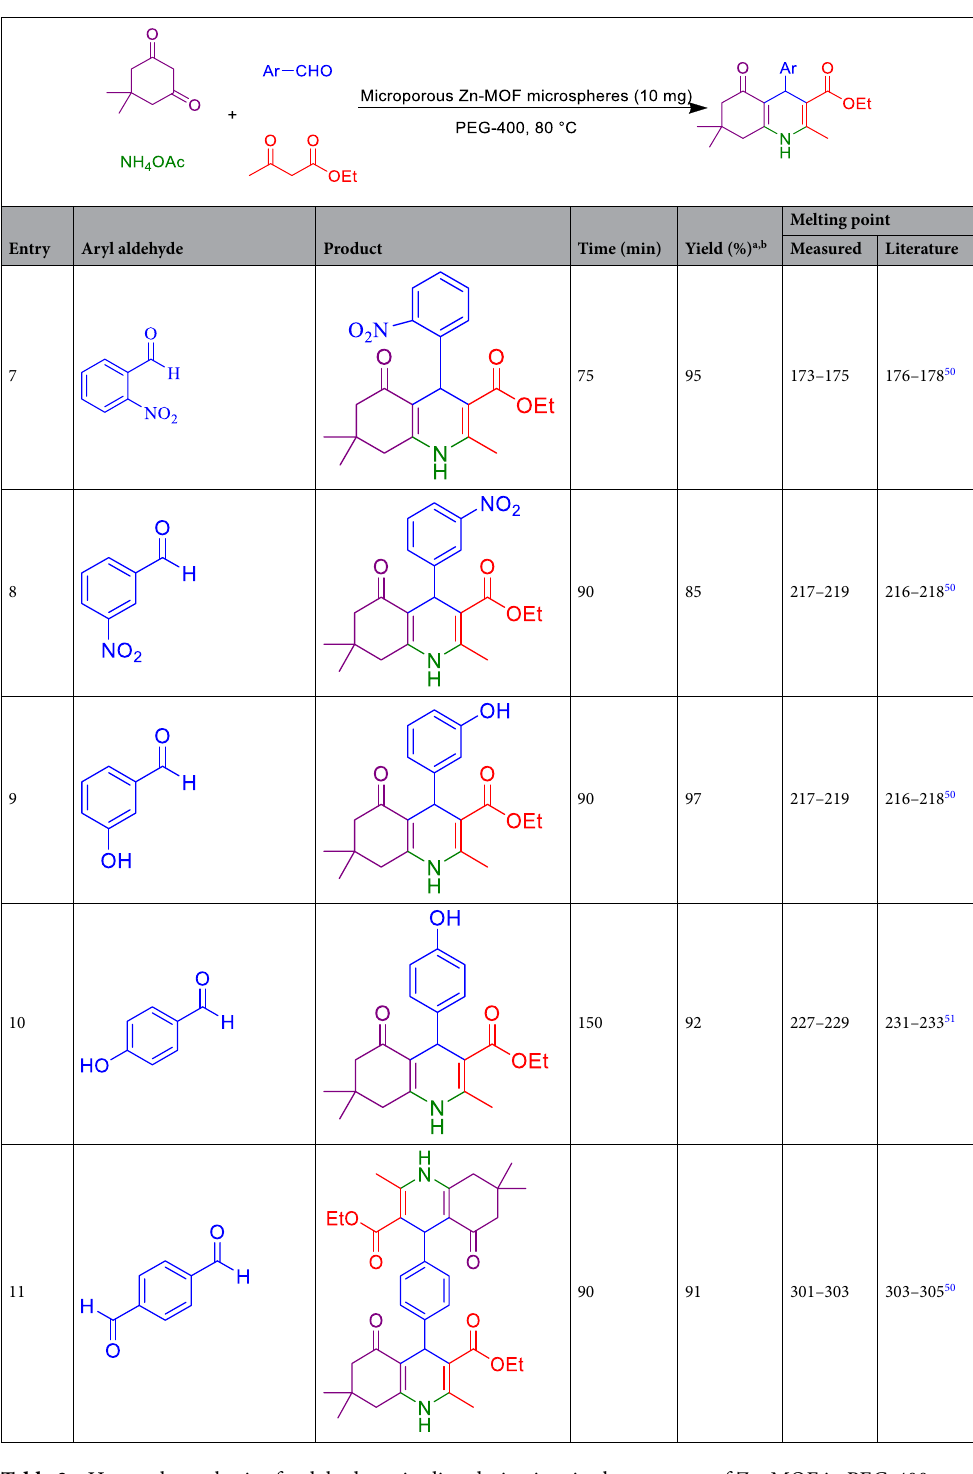
Table 2. Hantzsch synthesis of polyhydroquinoline derivatives in the presence of Zn-MOF in PEG-400 at 80 °C. a Isolated yields. b Reaction conditions: Aromatic aldehyde (1 mmol), dimedone (1 mmol),